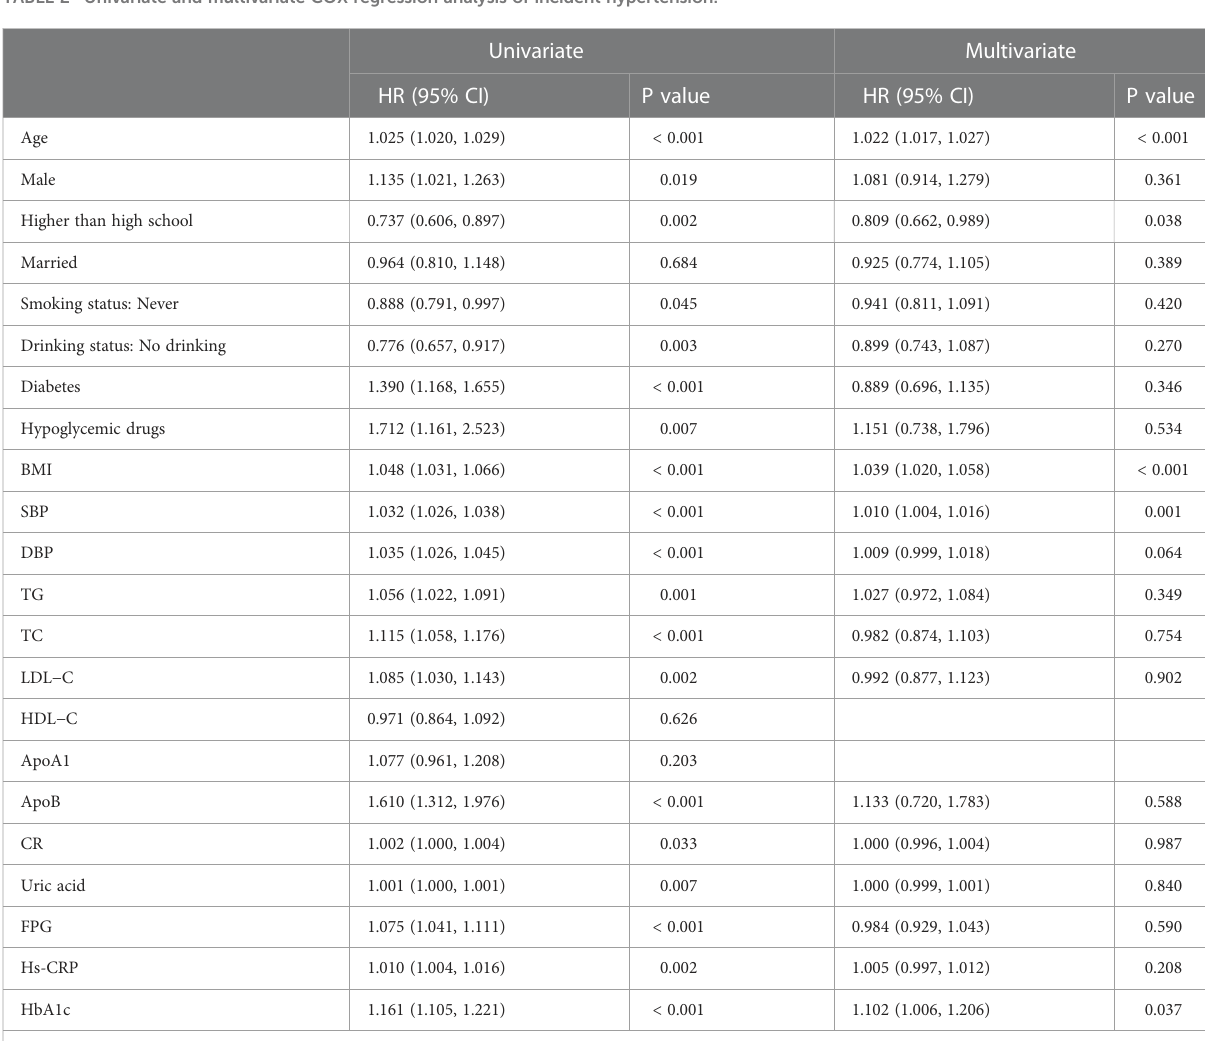
TABLE 2 Univariate and multivariate COX regression analysis of incident